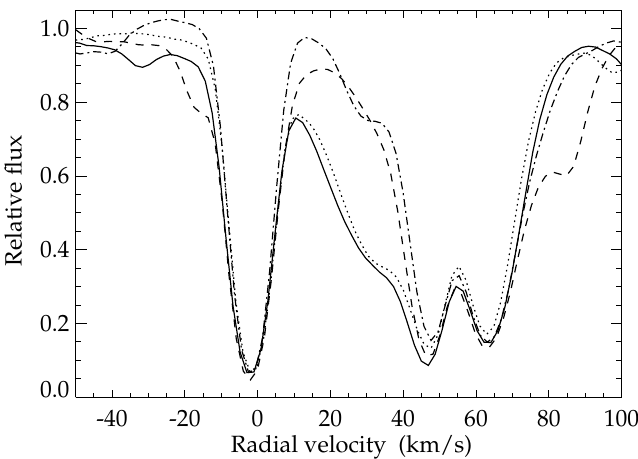
Fig. 10. The Na I D-lines in R Sct SAO spectra on two different dates: JD = 2455464.3: D 2 – solid line and D 1 – dotted line; JD = 2455408.5: D 2 – dashed line and D 1 – dash-dotted line. A good fit of interstellar lines on the two dates is accidental. In this figure the lines are plotted as observed, the velocities are not corrected for the solar motion.